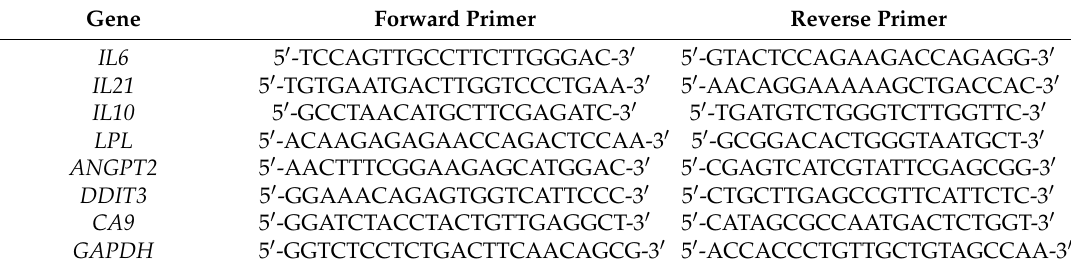
Table 1. Forward and reverse primers used in this